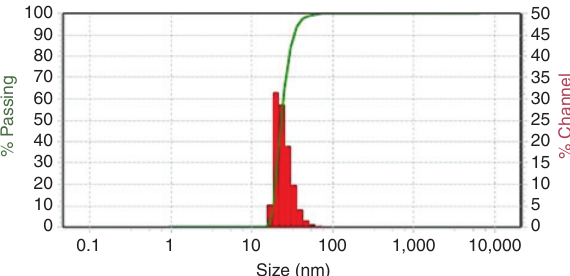
Figure 6: Particle size distribution of the synthesized AgNPs at obtained optimum synthesis